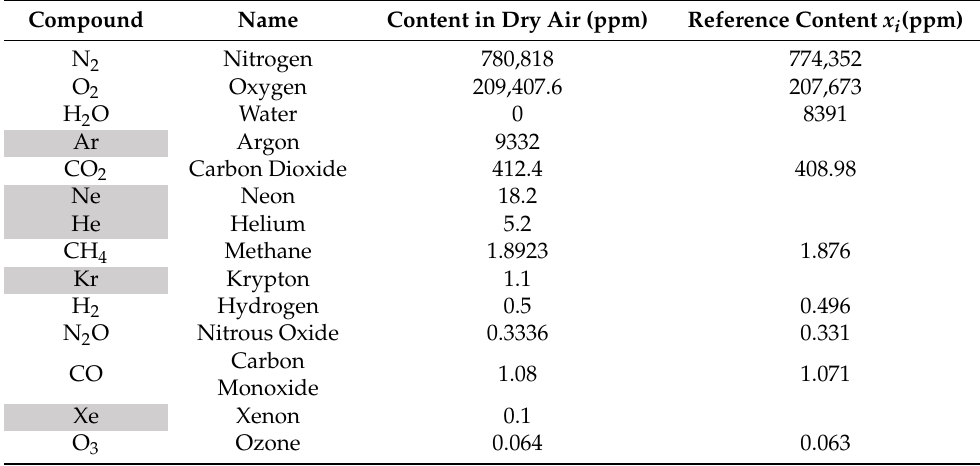
Table 2. Gas molar fractions of compounds used in this study. Reference content settings are values used when exporting from HITRAN data to numeric